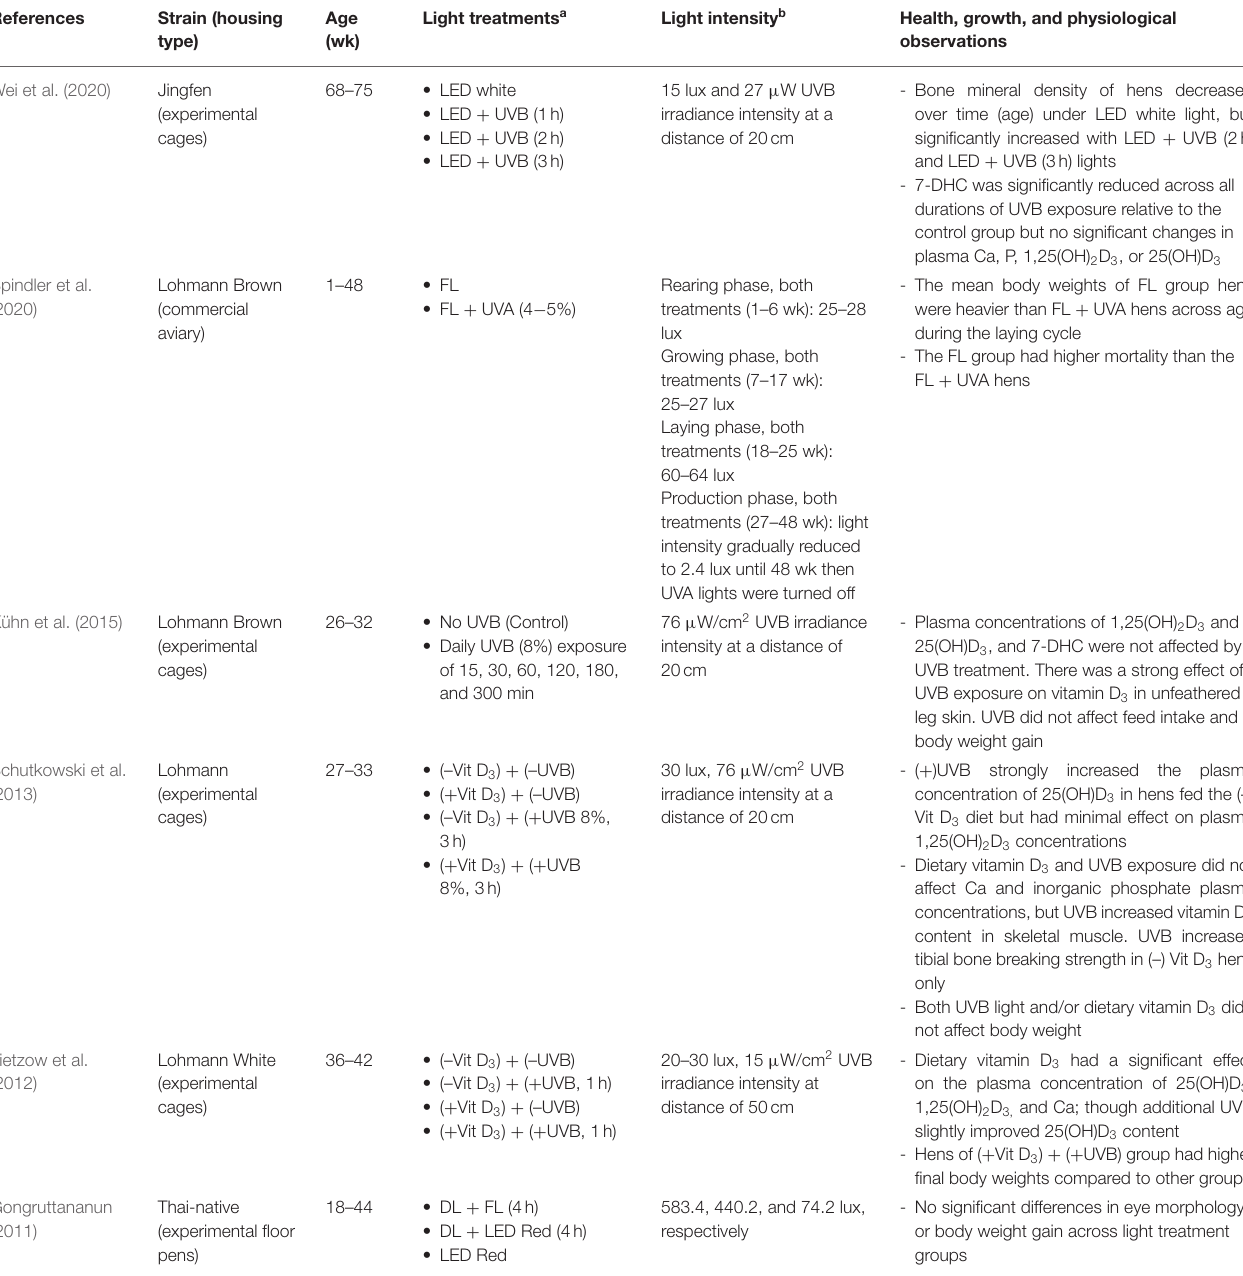
TABLE 2 | Effects of UV light on growth, physiology, and skeletal health of laying